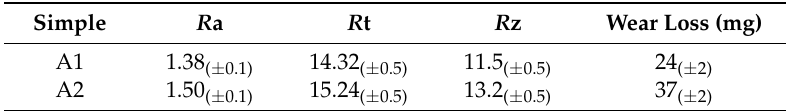
Table 5. Surface profile and weight loss of the Fe-Cr-B alloys after the abrasion test.